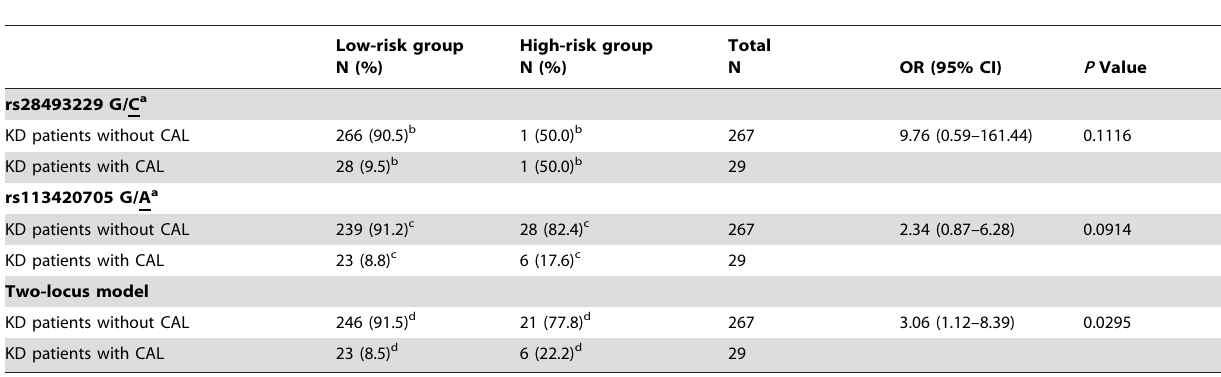
Table 2. Association of rs28493229 C allele and rs113420705 A allele with CAL in KD patients.